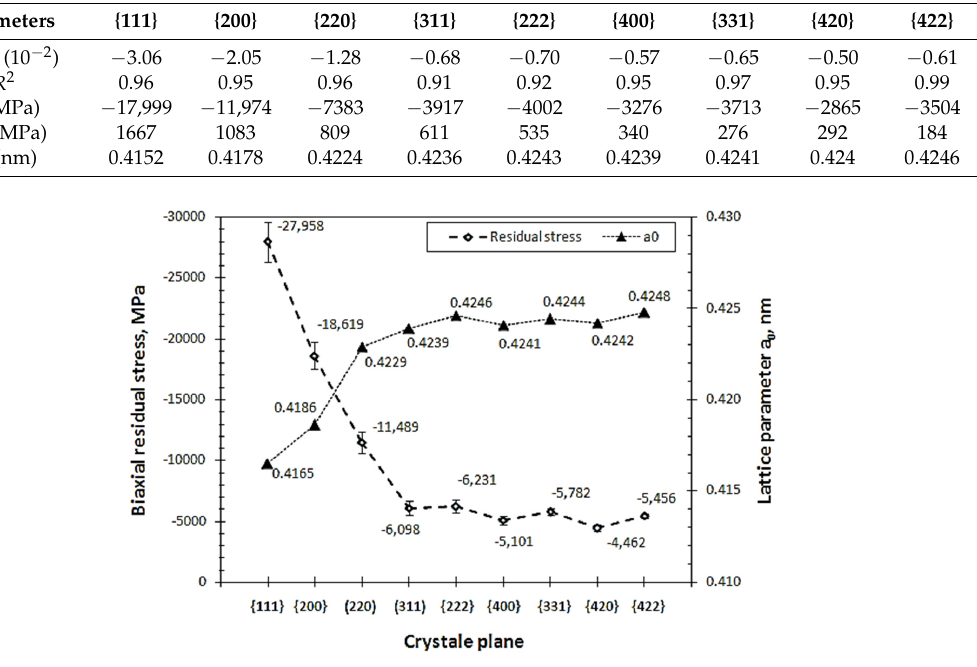
Figure 5. Residual stresses and stress ‐ free lattice parameters of the TiN following the { hkl } mode. In Figure 5, the high ‐ angle diffraction peaks from {311} to {422} give similar values of residual stress in a range of − 4.46~ − 6.23 GPa, each with a small deviation, Δσ . In particular, the calculated residual stress is irrelevant to the employed lattice planes. Meanwhile, the calculated stress ‐ free